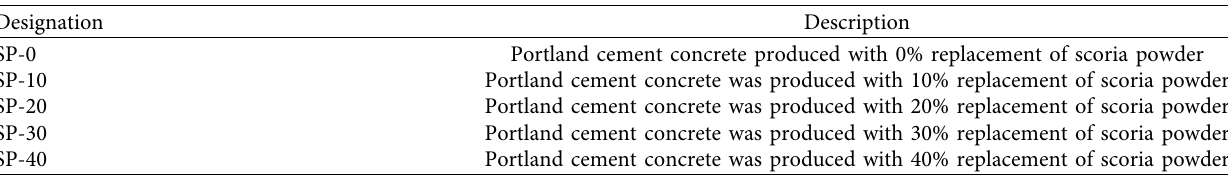
Table 6: Mix designations.